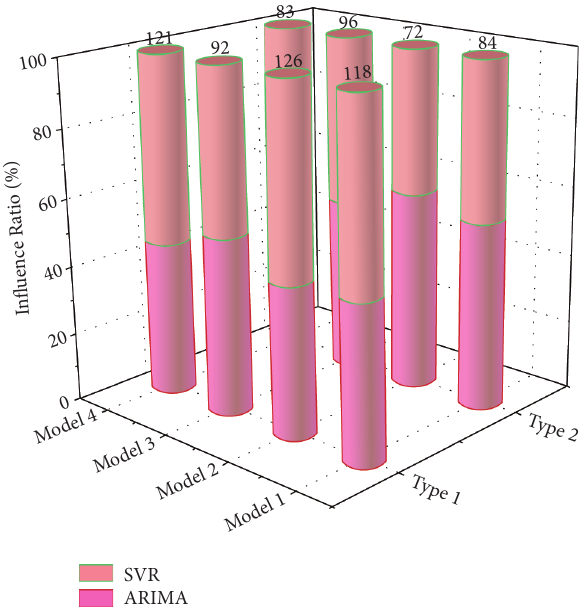
Figure 4: Sample size statistics for 4 types of wave patterns.